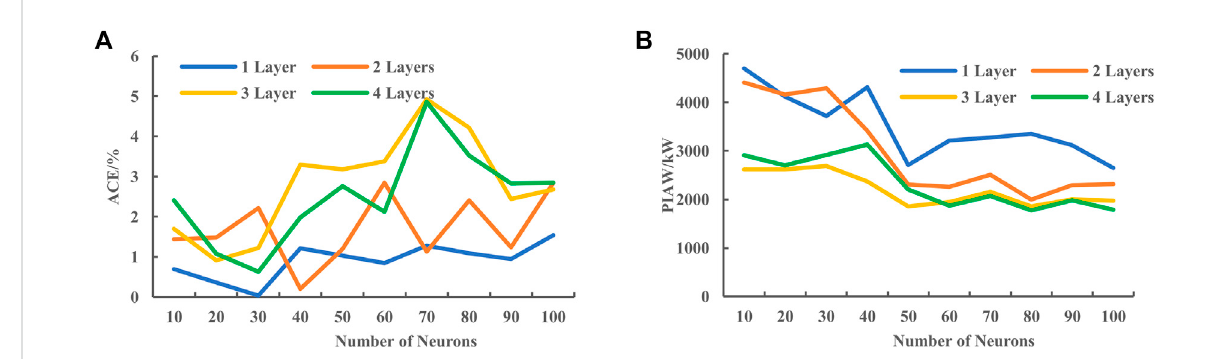
FIGURE 4 Impact of parameters on (A) ACE and (B) PIAW.